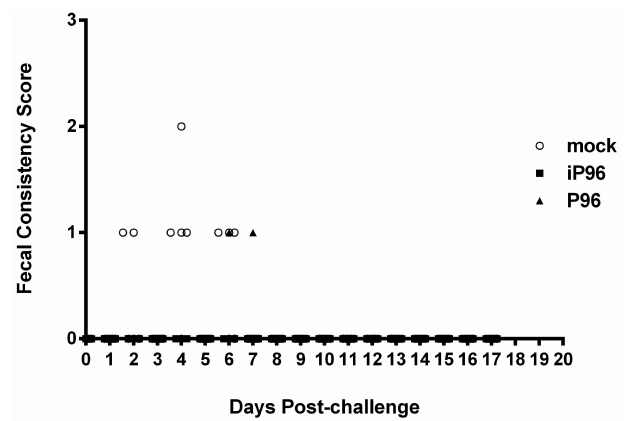
Figure 7. The fecal consistency score of piglets inoculated with the iPEDVPT-P96 virus ( (cid:4) ), the PEDVPT-P96 virus ( (cid:78) ), or the mock-inoculated ( ) after challenge with PEDVPT-P5. Each group (cid:35) consists of 5 piglets. The fecal consistency sign of each piglet was scored visually as 0 = normal, 1 = loose, 2 = semi-fluid, and 3 =